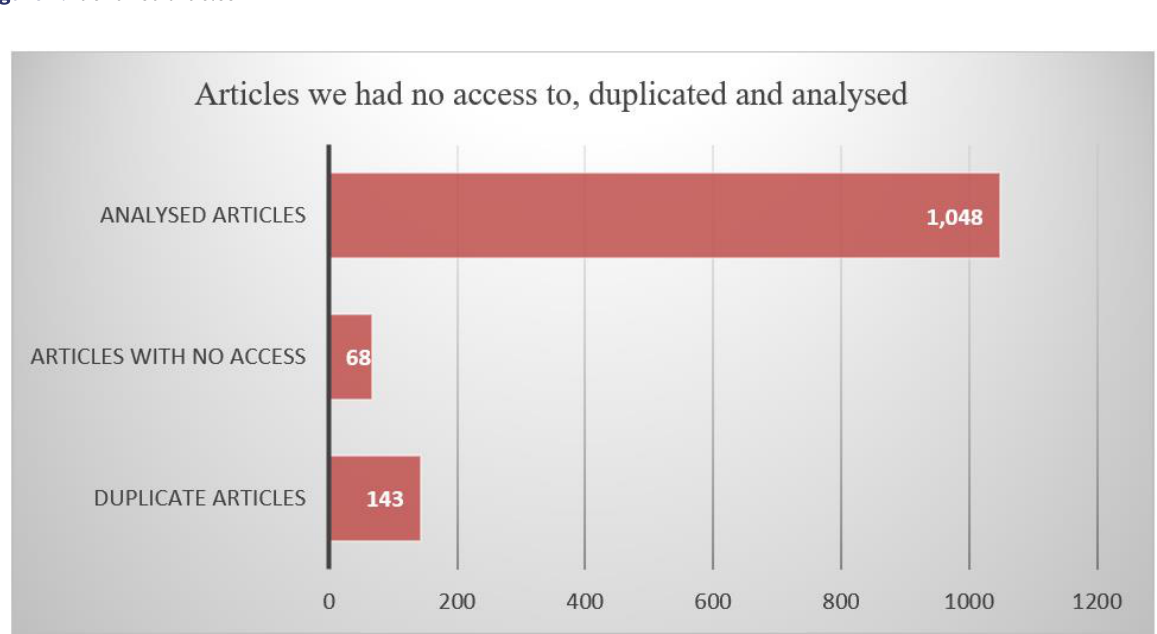
Figure 2. Filtering the identified